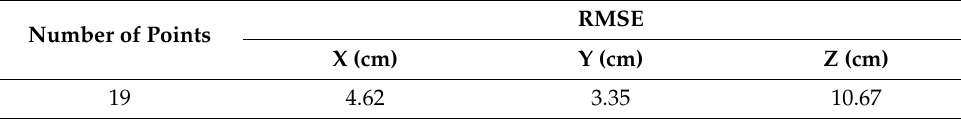
Table 1. RMSE checkpoint for photogrammetric products.